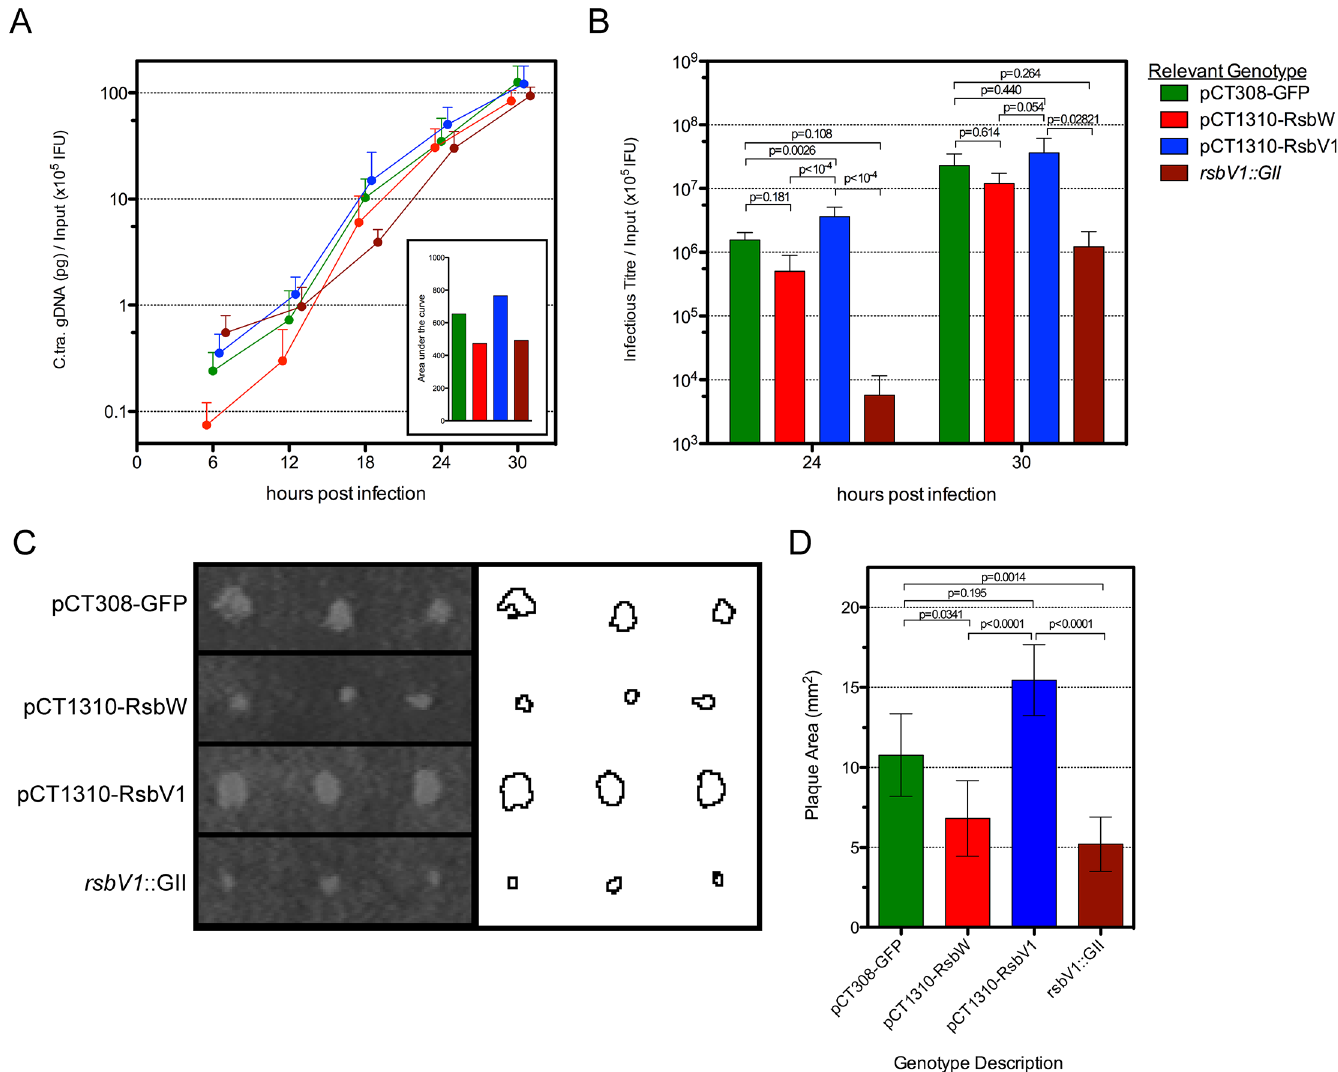
Fig 5. The effect of rsbW and rsbV1 expression on genomic replication and development of infectious progeny. 1-step and 2-step growth from time- course experiments were monitored for strain L2R harboring shuttle vector plasmids pCT308-GFP (green), pCT1310-RsbW (red), pCT1310-RsbV1 (blue), or from strain DFCT15 ( rsbV1 ::GII; maroon). The mean of C . trachomatis gDNA, normalized by the empirical IFU input (x10 5 ) is plotted by hours post-infection (A). The inset shows the area under each curve. The mean of recoverable infectious progeny from the same experiments was also normalized by empirical input (B). Error bars for both panels represent the 95% confidence interval. P-values derived from One-way ANOVA with Tukey ’ s multiple comparisons test performed in R. Plaque expansion from infection foci were measured using FIJI freeware (C). Bars represent mean plaque size (mm 2 ) from all foci at days 8 and 9 post-infection (D). Error bars represent 95% confidence intervals. P-values derived from One-way ANOVA with Dunn ’ s test for multiple comparisons using rank sums in R.